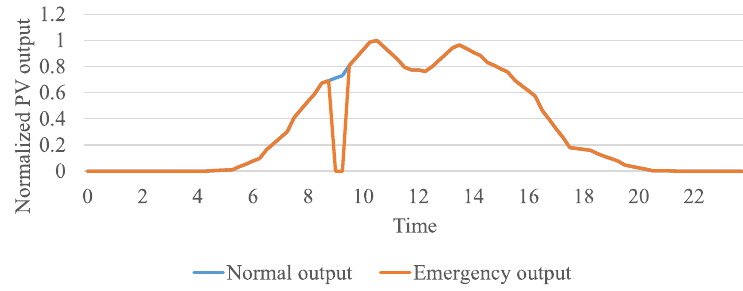
Figure 11. Photovoltaic output in emergency.